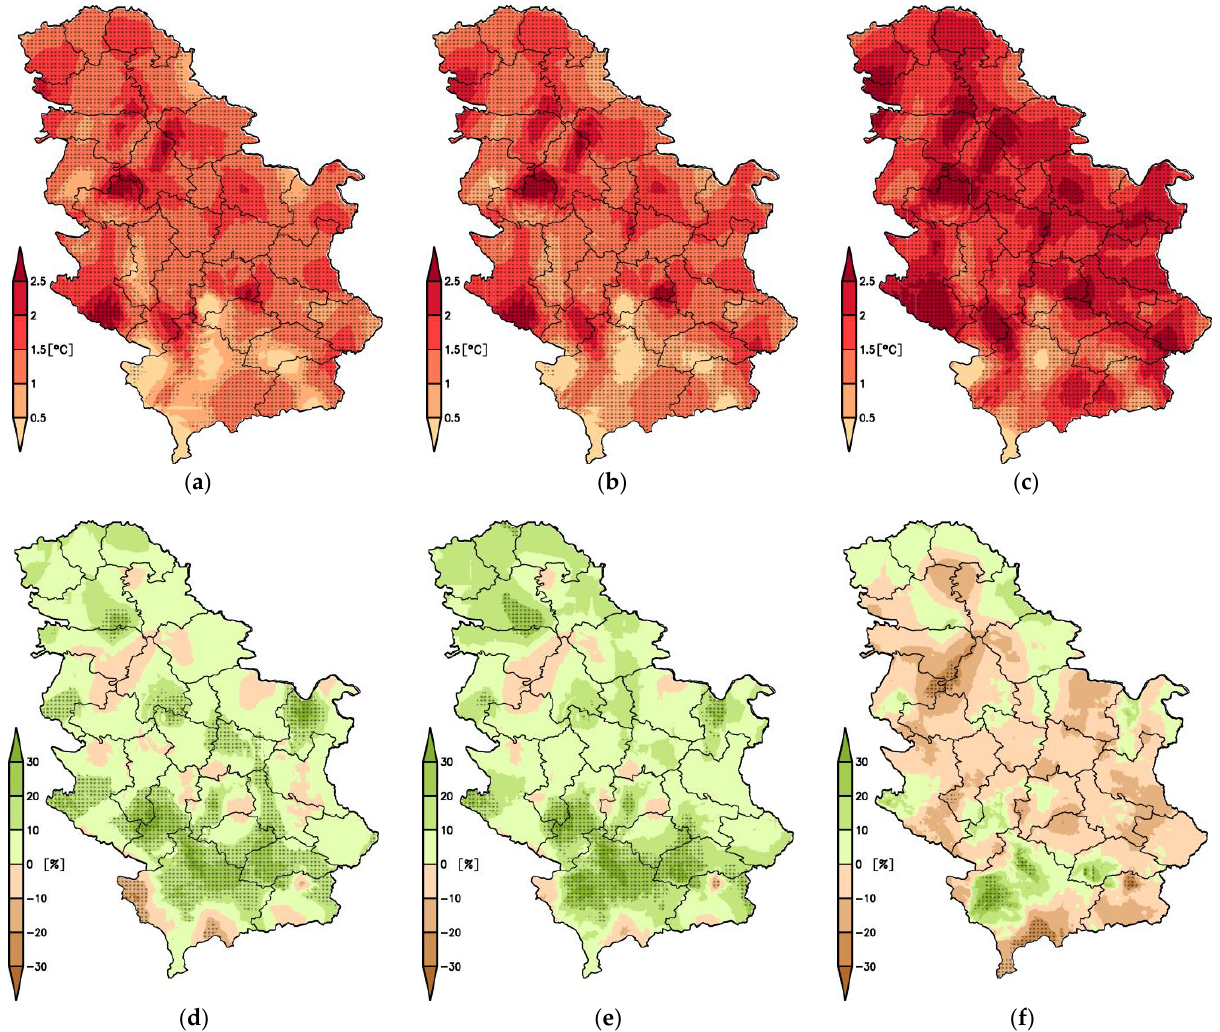
Figure 2. Mean temperature (°C) and precipitation (%) anomalies between periods 1961 – 1990 and 1998 – 2017. Black dots mark areas where the observed changes are statistically significant according to the t -test. ( a ) mean annual temperature anomaly; ( b ) mean vegetational (April – October) temperature anomaly; ( c ) mean summer (June, July, August) temperature anomaly; ( d ) annual precipitation anomaly; ( e ) vegetational precipitation anomaly; ( f ) summer precipitation anomaly.